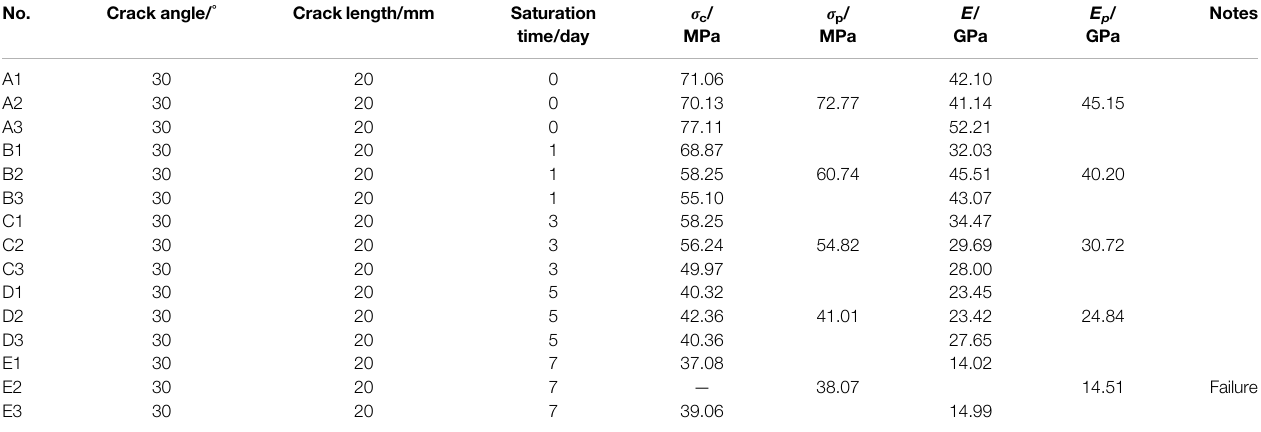
TABLE 2 | Mechanical parameters of jointed limestone with different water saturation time under uniaxial compression.